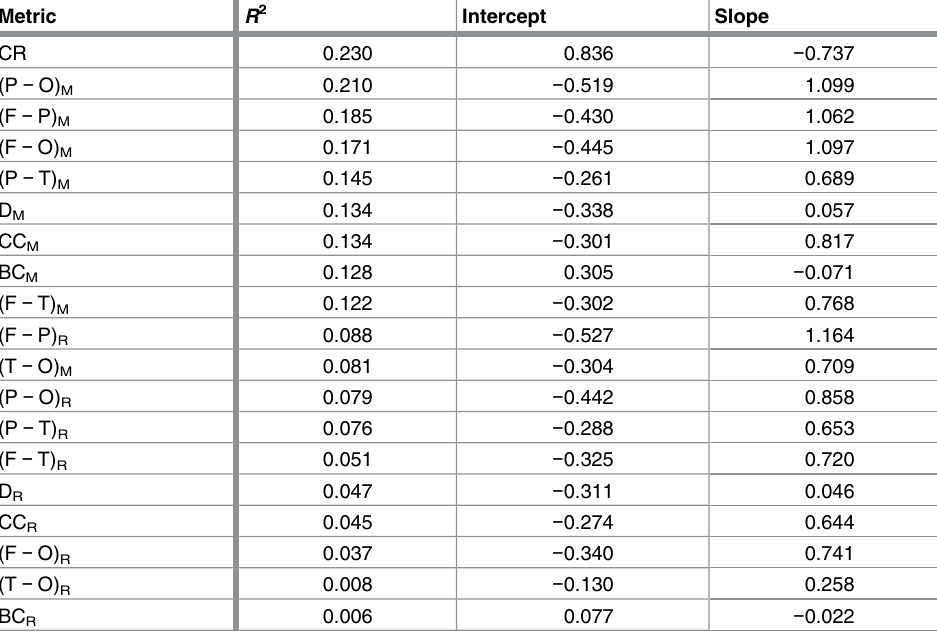
Table 4. OLS Regression. M: Maintenance, R: Retrieval. Metric R